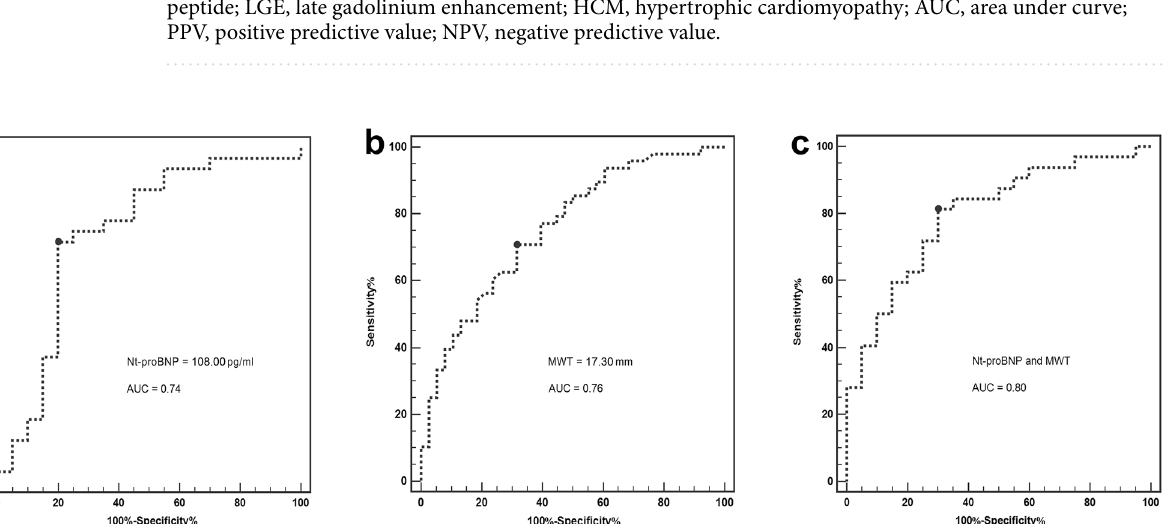
Table 4. Diagnostic performance of MWT, GCS and Nt-proBNP for identifying the presence of LGE. MWT, maximum wall thickness; GCS, global circumferential strain; Nt-proBNP, N-terminal pro b-type natriuretic peptide; LGE, late gadolinium enhancement; HCM, hypertrophic cardiomyopathy; AUC, area under curve; PPV, positive predictive value; NPV, negative predictive value.